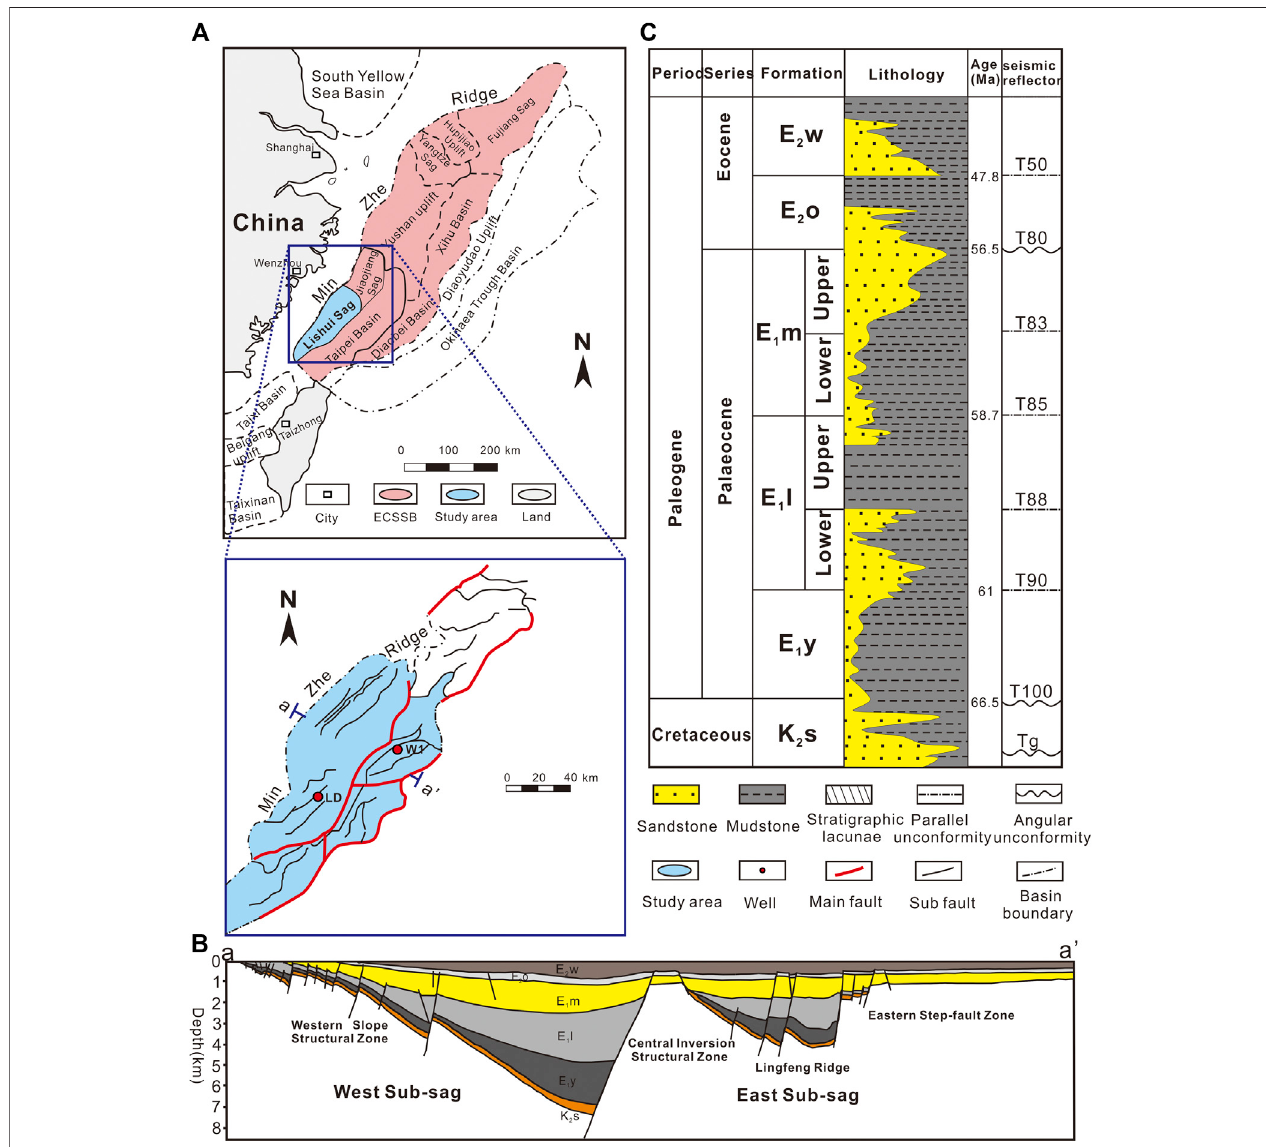
FIGURE 1 | Geographical location (A), structural features (B), and stratigraphic column (C) of the Lishui Sag.